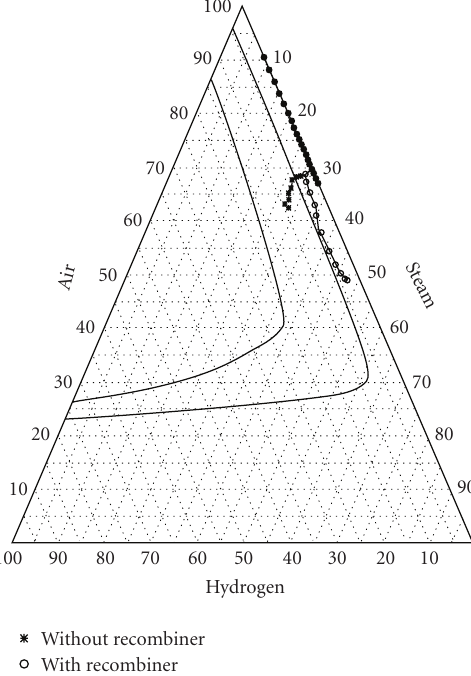
Figure 6: E ff ect of PARs on gas mixture flammability (with stars: gas composition without PARs; with circle: gas composition with PARs).